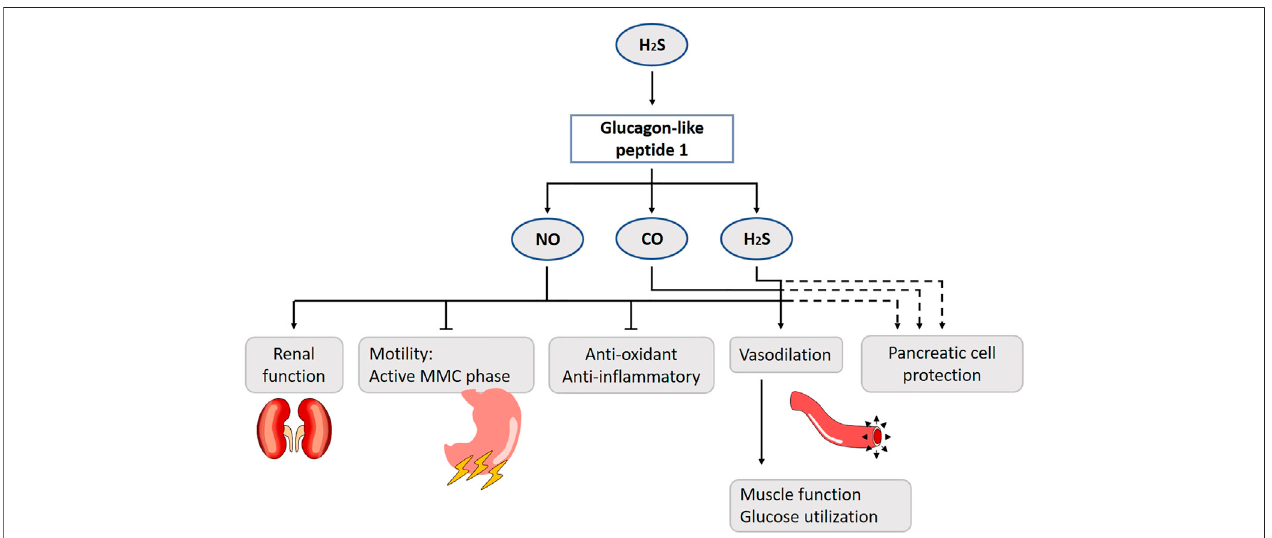
FIGURE 9 | Role of gasotransmitters on glucagon-like peptide 1 (GLP-1) release and its physiological functions. Solid lines are clear evidence – based on blockers and substrate administration. Dotted lines represent fi rst evidence for the presence of the pathway. H 2 S stimulates GLP-1 release. The suppression of gut motility, reduction of nephropathy risk factors, increase of muscle microvasculature, reduction of the number of reactive oxygen species and production of vasoconstrictive